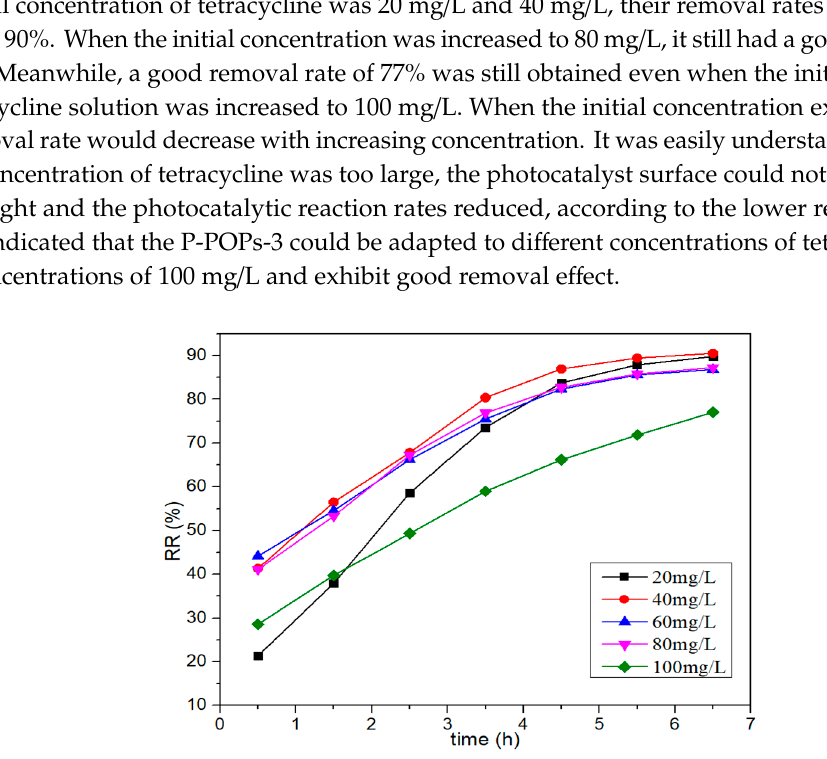
Figure 6. Effect of catalyst amounts on the removal rate of tetracycline. Reaction conditions: 20 mg/L tetracycline solution 40 mL, dark reaction 0.5 h, light reaction 6 h.